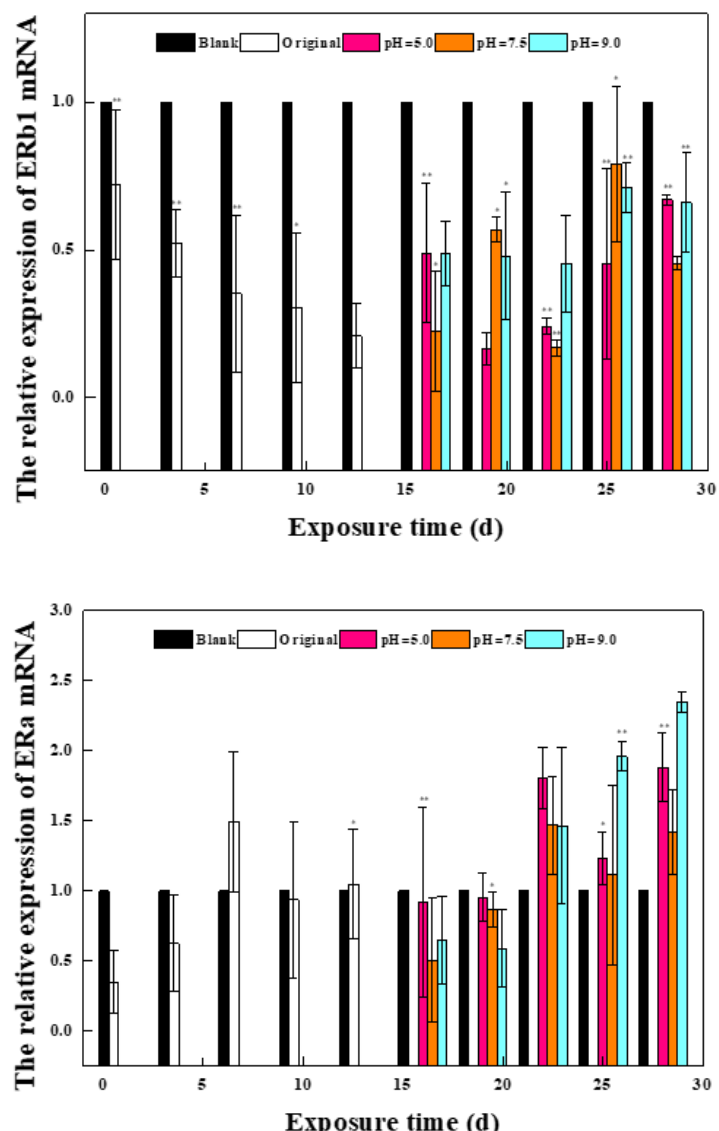
Figure 1. Effects of BPC and BPZ on mRNA expression levels of oxidative stress-related genes in zebrafish ( n = 3) (Note: 0.01 < * p < 0.05; ** p < 0.01, compared with the control group). 2.2. Effects of a Mixed Solution of BPC and BPZ on the Expression of Oxidative Stress-Related Genes and Estrogen Receptor Genes in Zebrafish 2.2.1. Effects of Mixed Solution at the First Stage on Antioxidant Enzyme Activity and MDA Content in Zebrafish